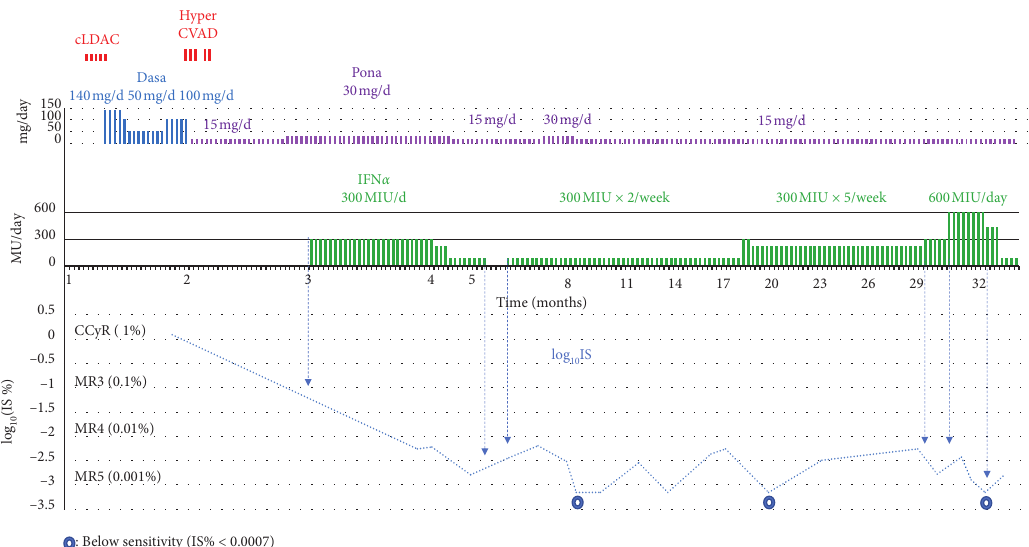
Figure 1: Clinical course of de novo blast crisis. Abbreviation: Nilo, nilotinib; Dasa, dasatinib; Pona, ponatinib; cLDAC, continuous infusion of low dose cytarabine (AraC); Hyper CVAD, hyperfractionated cyclophosphamide, vincristine, doxorubicin (adriacin), and